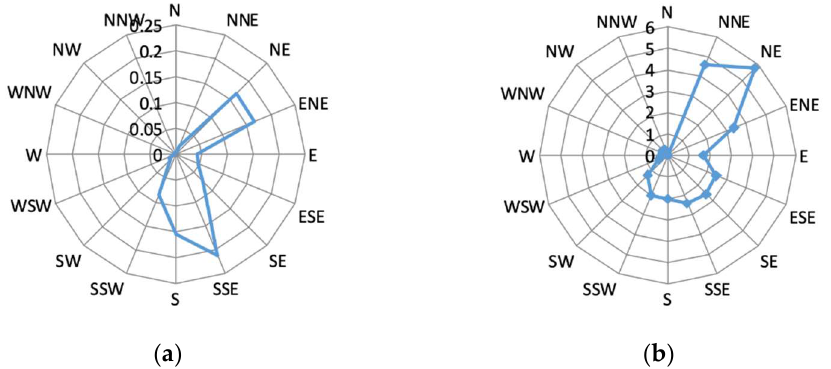
Figure 2. Wave rose diagram at point A ( a ) and Wave rose diagram of maximum wave height at point A ( b ).